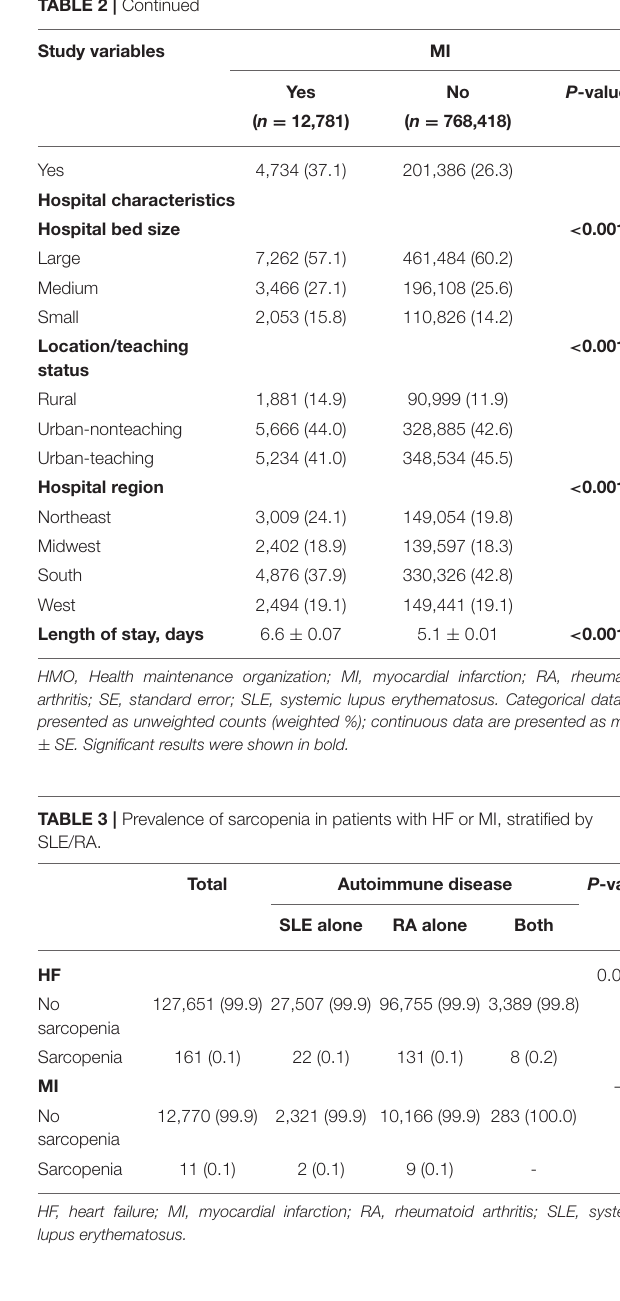
TABLE 2 | Characteristics of SLE/RA patients with or without MI.